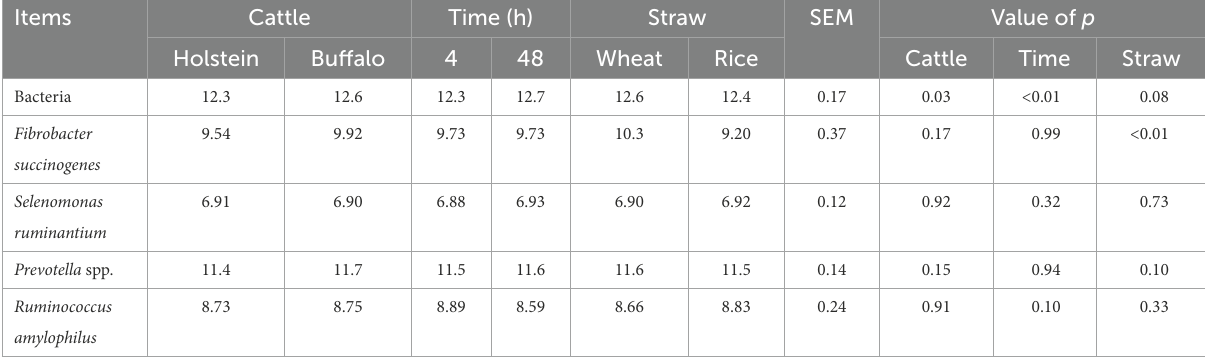
TABLE 3 Selected microbial groups (log 10 gene copies per g rumen content) attached to rice and wheat straws at 4 and 48 h of in situ incubation time in buffalo and Holstein rumen. Items